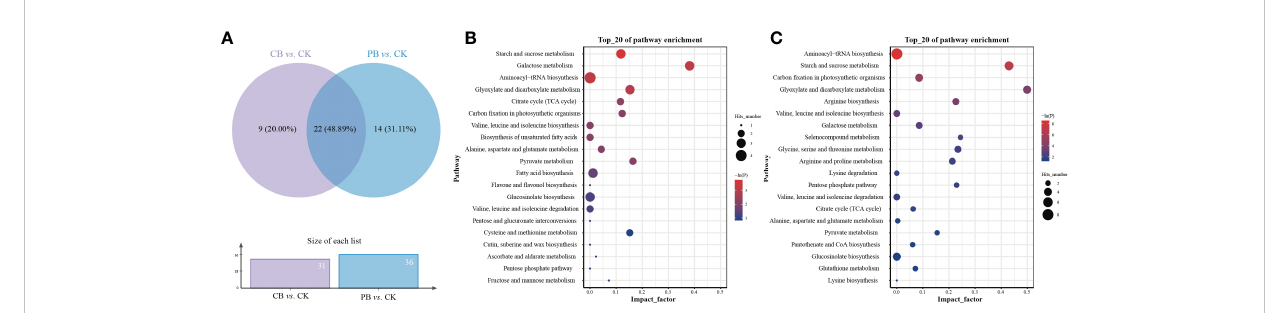
FIGURE 4 Enrichment result of differential metabolites in KEGG metabolic pathways. (A) Venn diagram showing the unique and shared differential metabolites from the Bletilla pseudobulb of intercropping vs . monoculture. The bubble map of metabolite pathway enrichment analysis in the Bletilla pseudobulb of intercropping vs . monoculture, (B) indicates the C. paliurus intercropping with B. striata (CB) vs. Control; (C) indicates the Moso bamboo intercropping with B. striata (PB) vs.